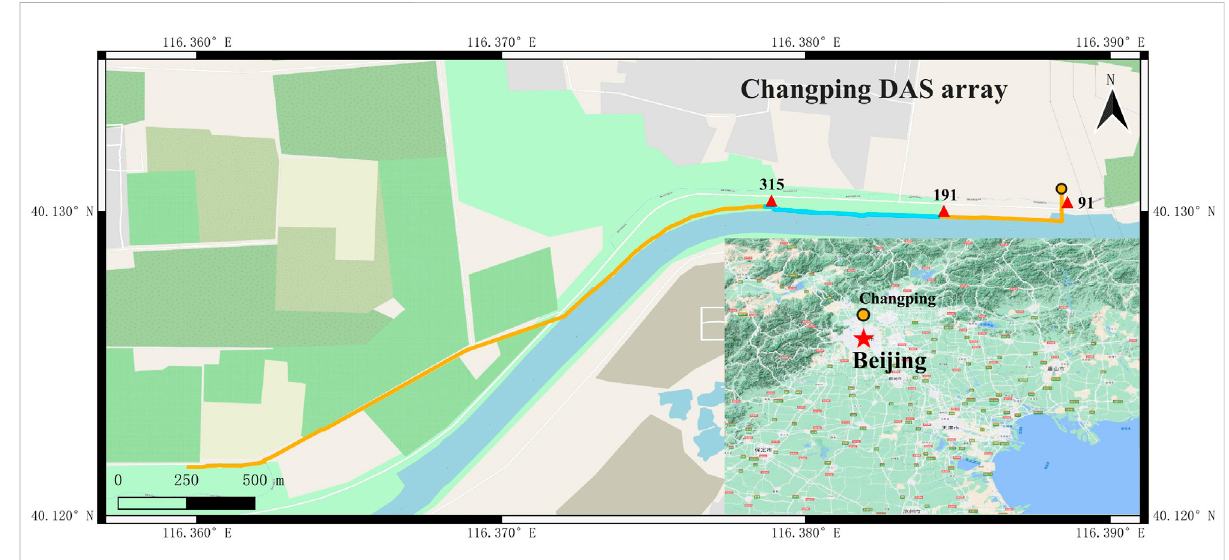
FIGURE 1 DASarrayinChangping,Beijing.Theyellowlineistheopticalcable,andtheyellowcircleindicatesthelocationoftheDASinterrogator.Weused data from the sub-array (No. 191 – 315, blue line) and No. 91 (one of the cross-road channels) for traf fi c